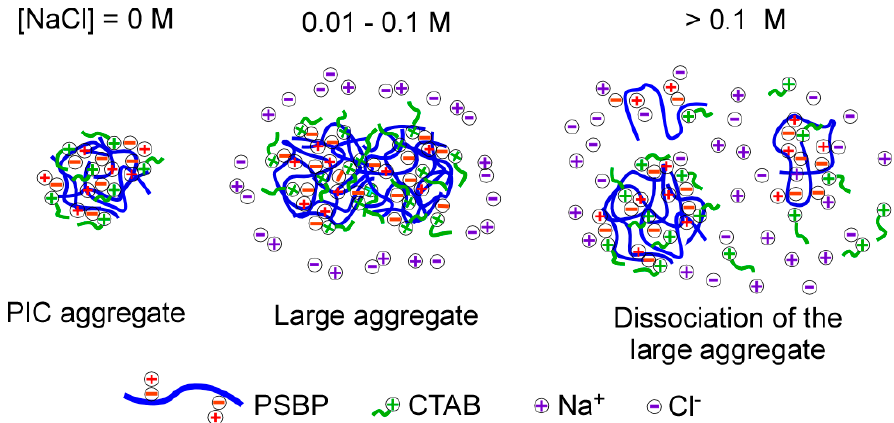
Figure 7. Schematic illustration of the effect of [NaCl] on the formation of the PSBP/CTAB complex.